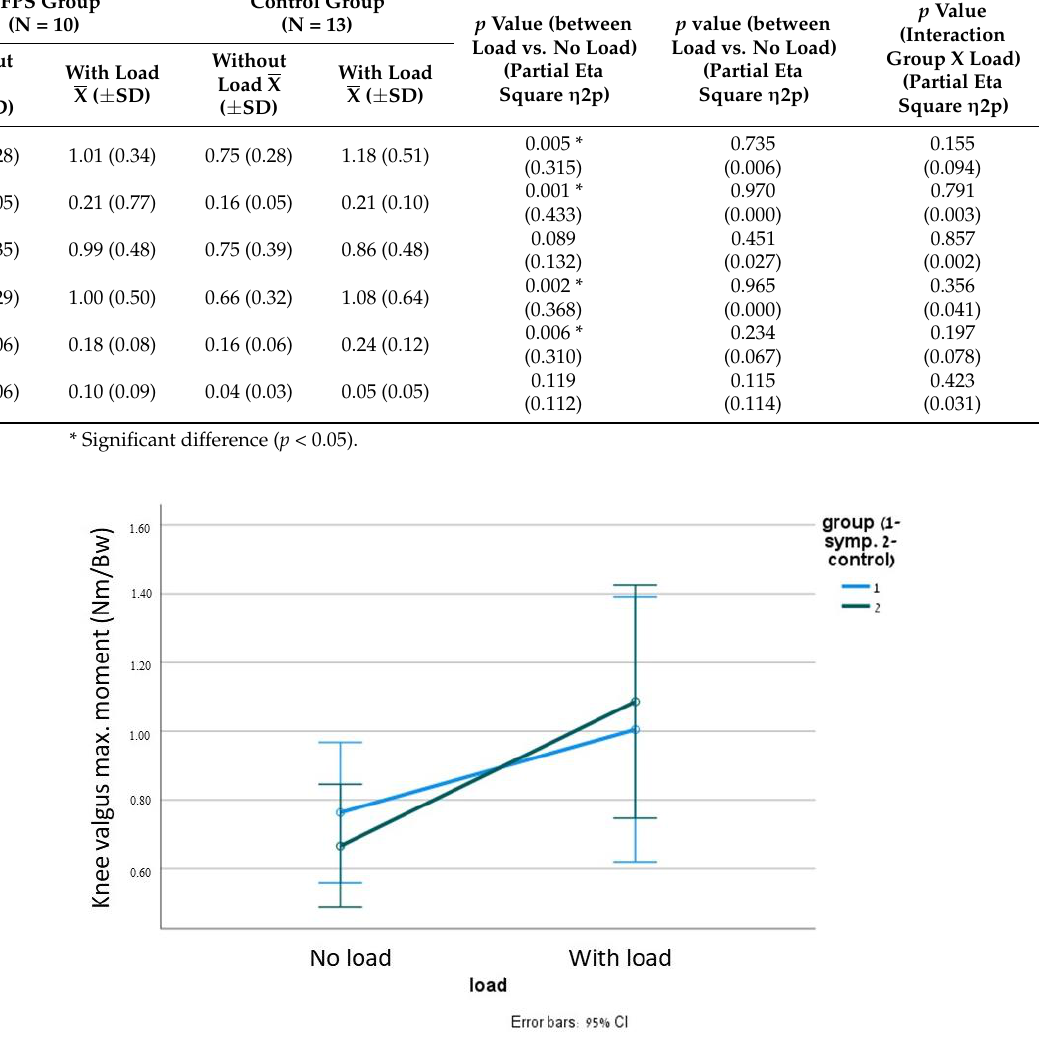
Figure 5. Maximal knee joint valgus moment in both groups.